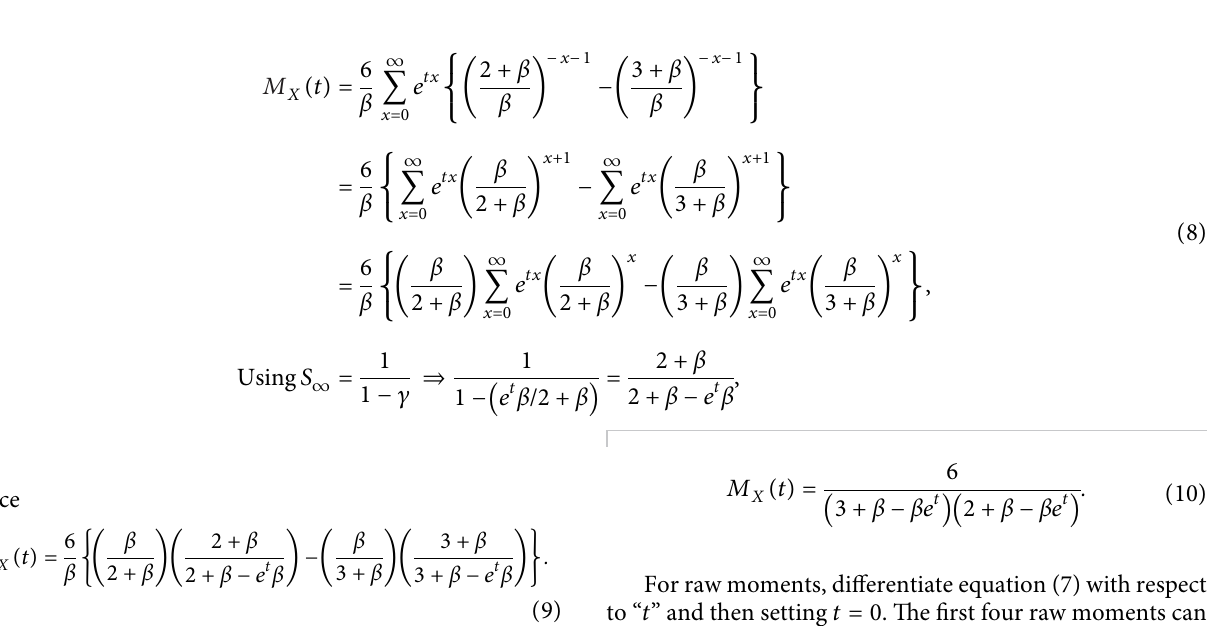
Figure 1: Te PMF plots of DPB